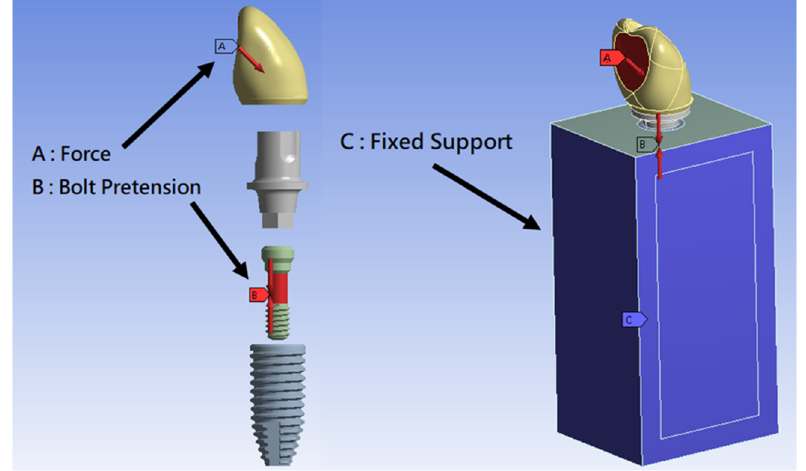
Figure 4. Loading condition on all models (A, lateral force of 170 N applied at the palatal side of the upper incisor crown with 45° to the long axis of the implant; B, bolt pretension with the axial force on the screw; C, fixed supported bone housing model).